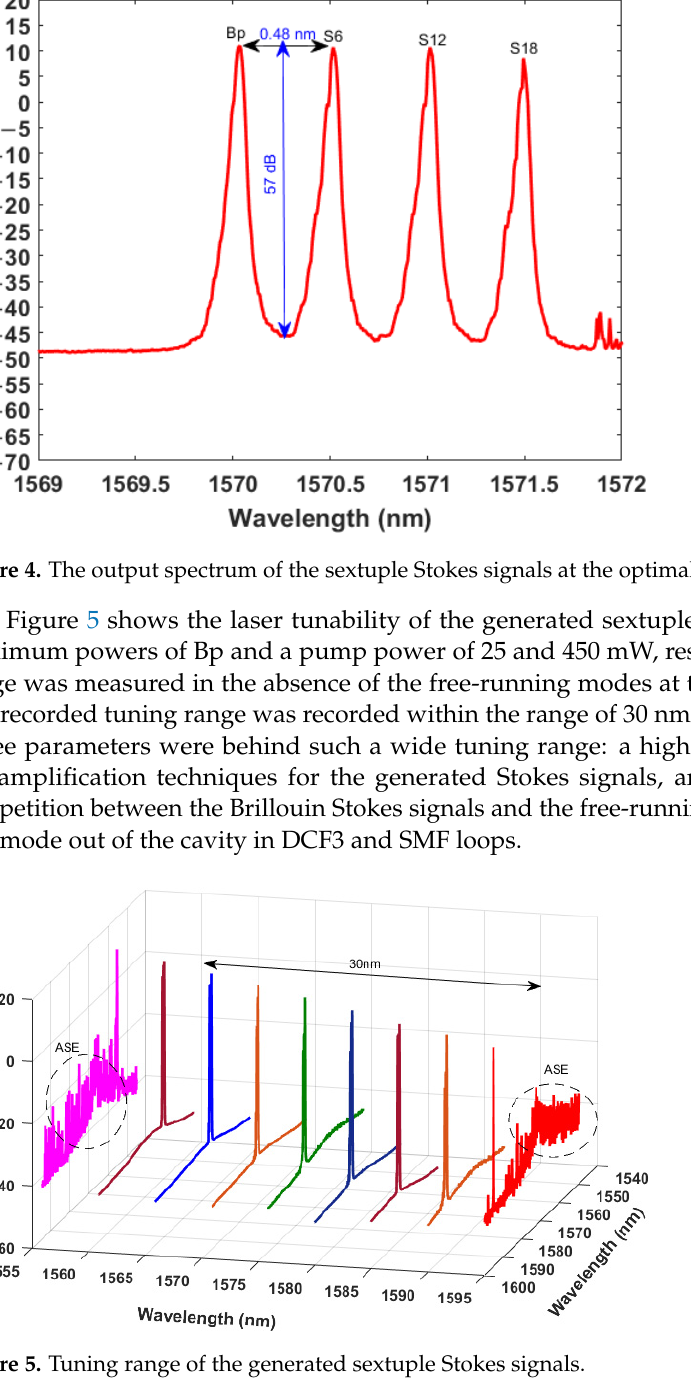
Figure 3. Threshold values of the sextuple Stokes signals.